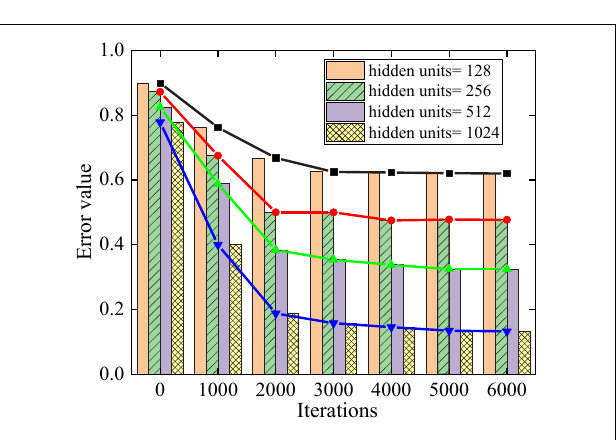
FIGURE 7 | Influence of the number of hidden layer neurons on error.